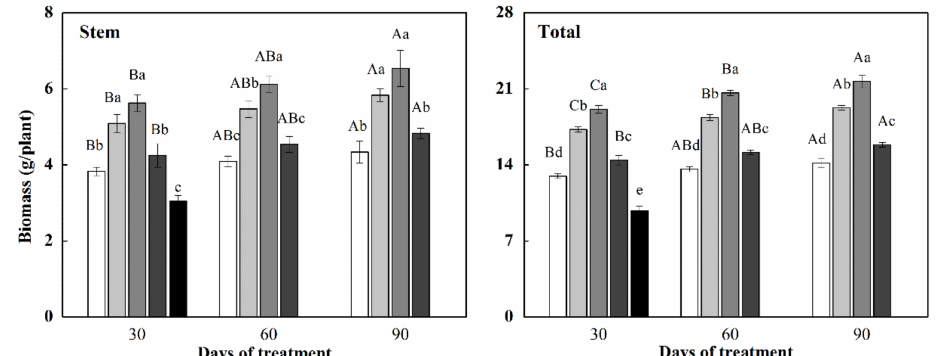
Figure 2. Effects of NO 3− /NH 4+ ratio on biomass in different components of Cyclocarya paliurus (Batalin) Iljinsk. seedlings sampled at 30, 60 and 90 days after treatments. Different capital letters indicate significant differences among different NO 3− /NH 4+ ratio treatment for the same sampling time according to Tukey’s test ( p < 0.05). Different small letters indicate significant differences among different sampling time for the same NO 3− /NH 4+ ratio treatment according to Tukey’s test ( p < 0.05). All C. paliurus seedlings had died at 52 days after the treatment in T5.